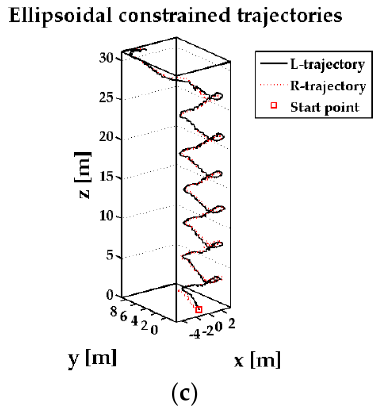
Figure 6. The trajectories of the feet in upstairs experiment. ( a ) feet trajectories without constraint; ( b ) feet trajectories with spherical constraint; ( c ) feet trajectories with ellipsoidal constraint.